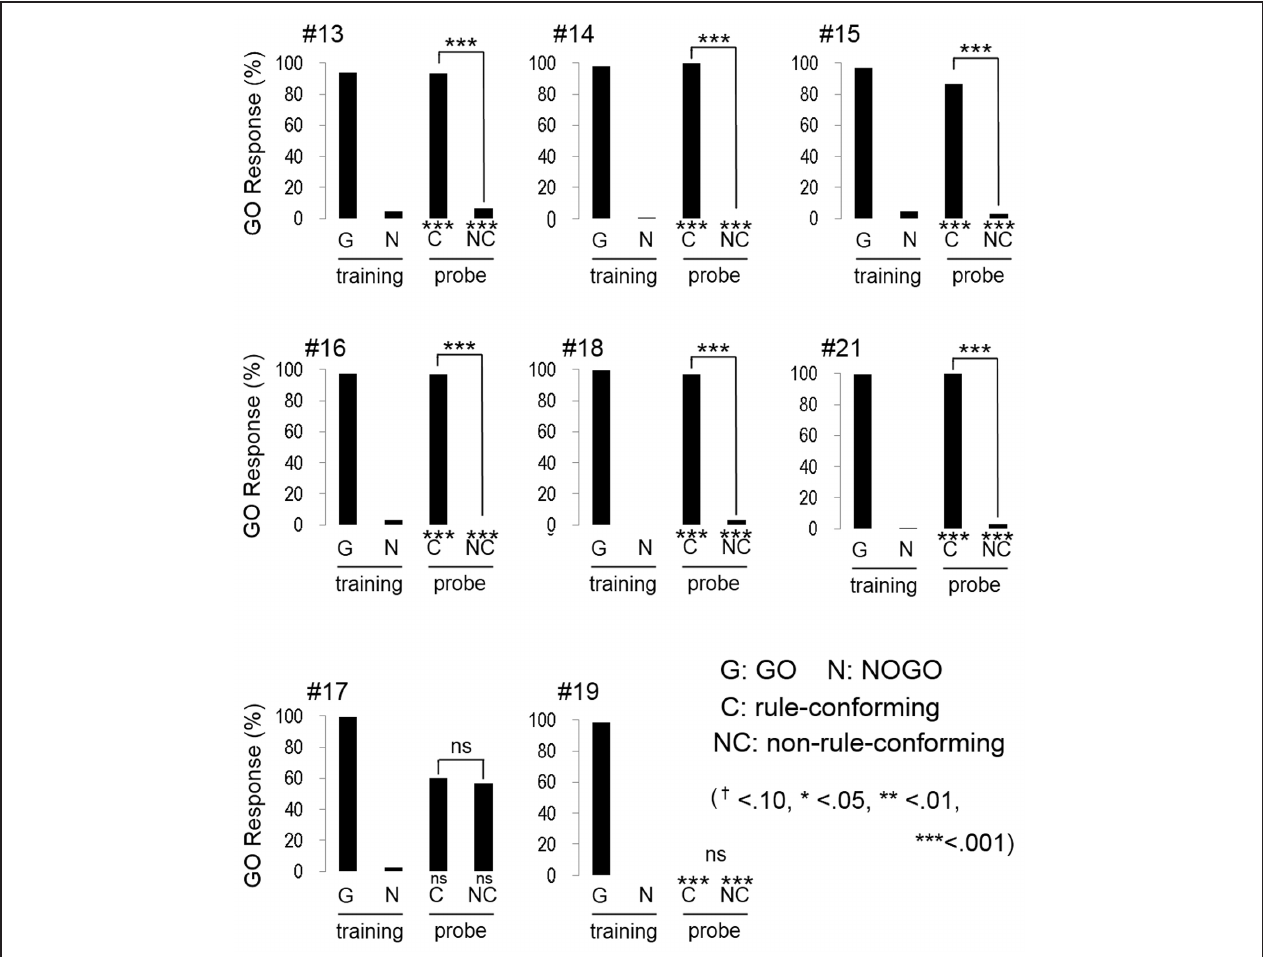
FIGURE 4 | Responseofhumanparticipantsinthebirdvocalizationexperiment. Sixparticipants (#13,#14,#15,#16,#18,#21)extracted theabstract rule.One participant (#17) showed unsystematic response to the probe stimuli.The response pattern of#19 isquite similarto the response ofbird #12 asshown in Figure 2 .